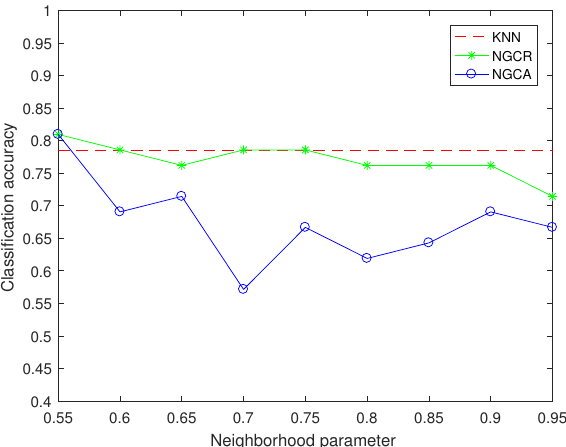
Figure 7. Classification accuracy for the segmentation